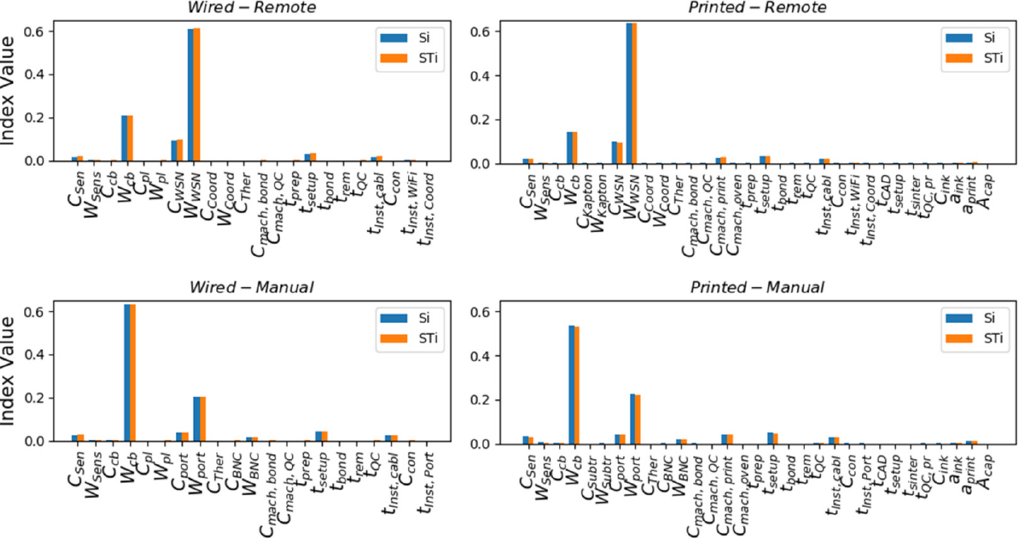
Figure 10. Sensitivity Index ( S i ) and the Total Effect Index ( S Ti ) for the parameters influencing C Total .